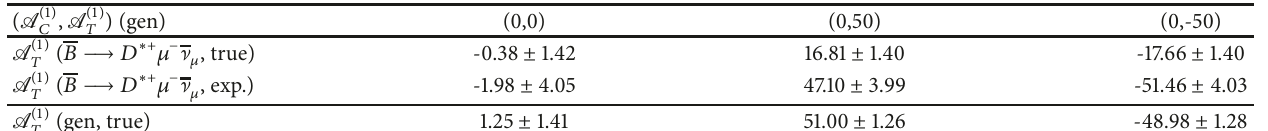
Table 4: Measured A (1) 𝑇 (in %) fitting the angular distribution equation (10)or the polynomial expansions equation (20)to the 𝐵 󳨀→ 𝐷 ∗+ 𝜇 − ] 𝜇 test sample for varying generated values; the last row reports the ideal sensitivity obtained from a toy sample generated from the true angular distribution with the same number of events of the test sample, fitted with the same distribution.